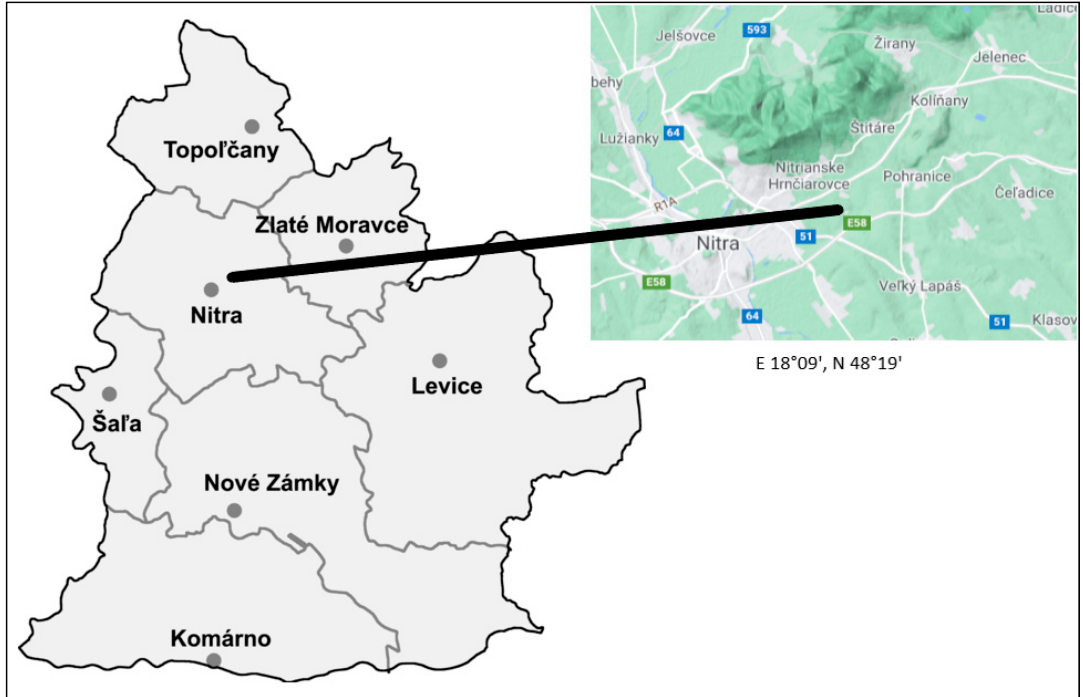
Figure 11. Illustration of experimental locality. Area is located in Podunajská nížina—Lowland, near Nitra city and Zobor hill in southwestern part of Slovak Republic.